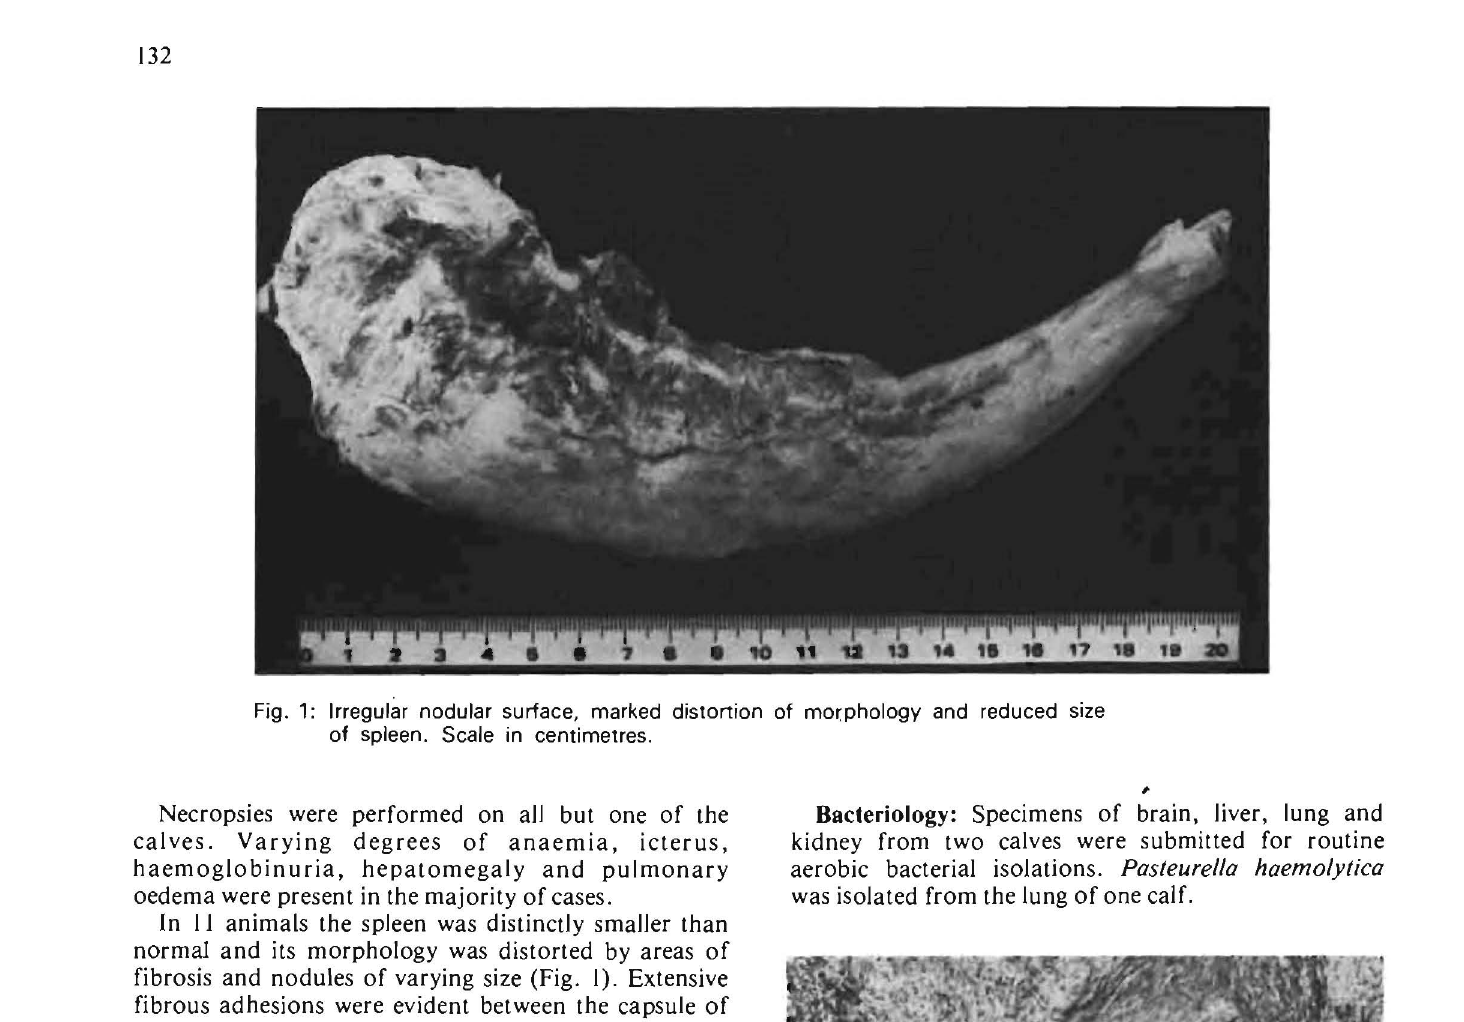
Necropsies were performed on all but one of the calves.